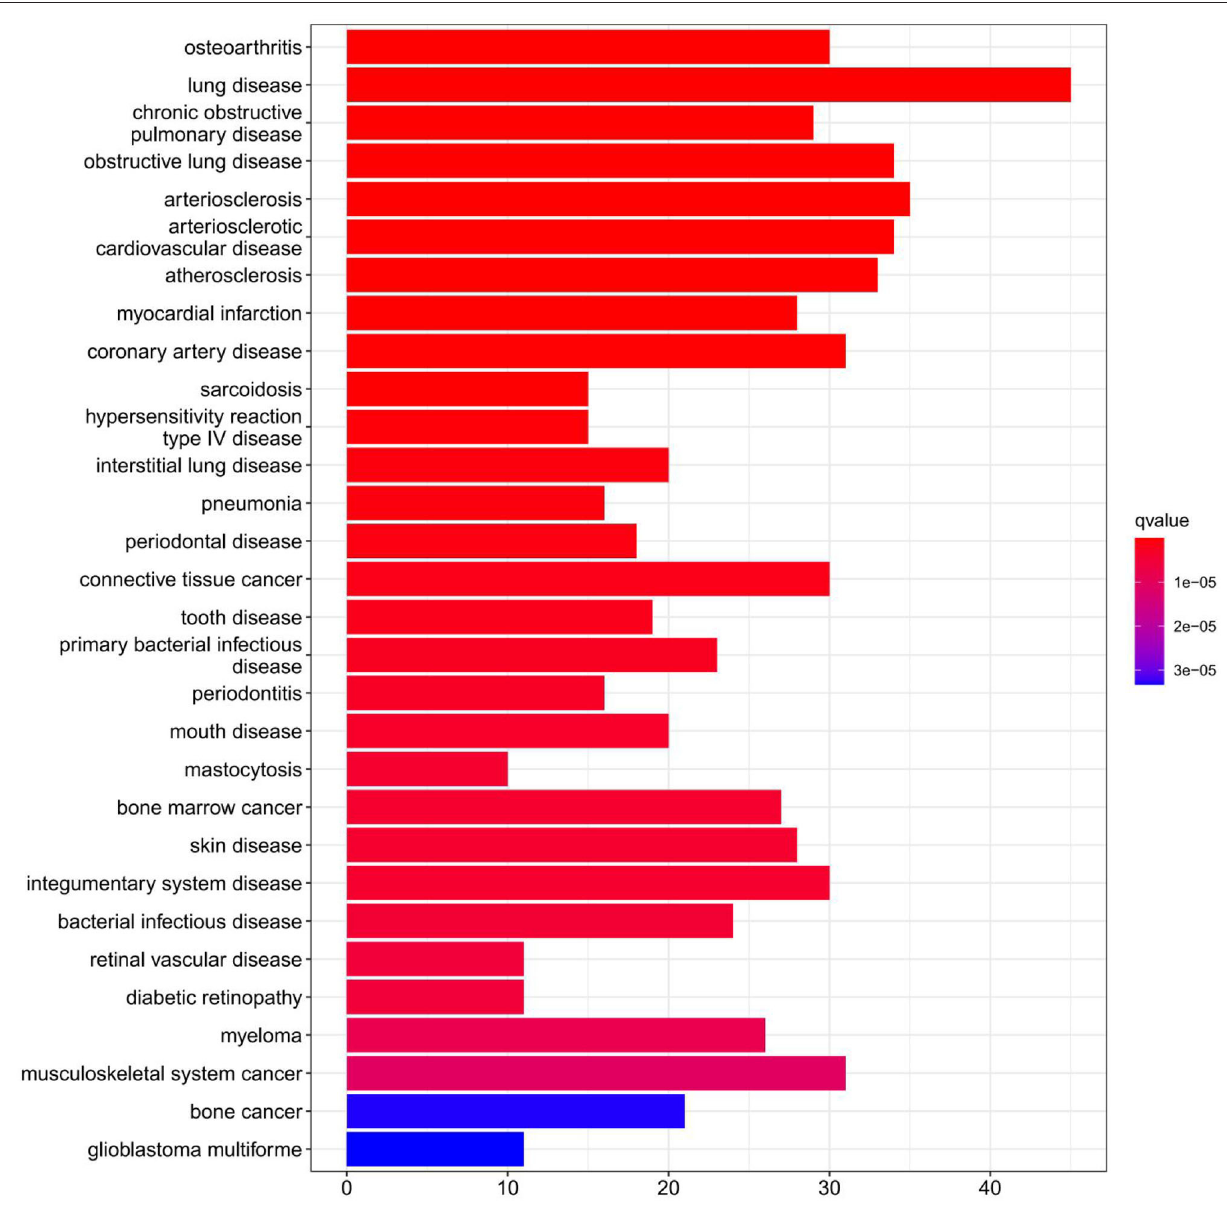
evaluate and utilize massive amounts of sequencing data